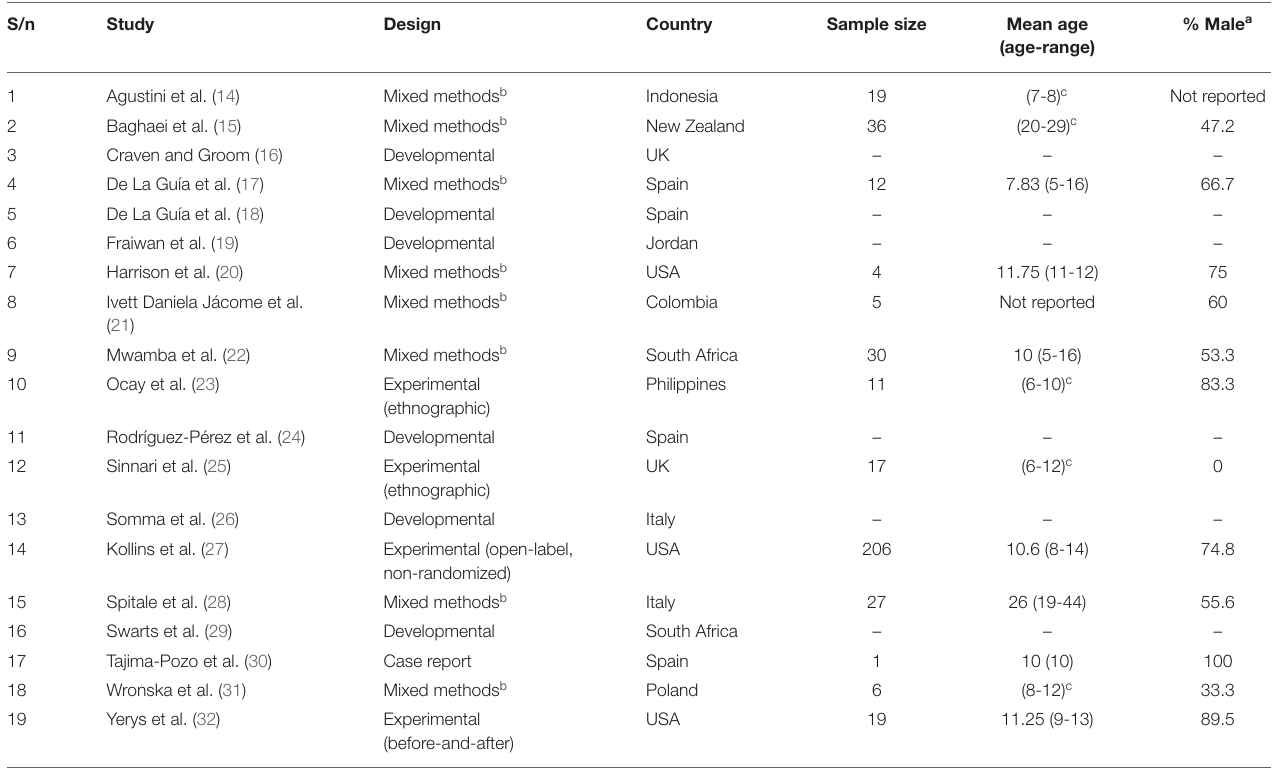
TABLE 1 | General characteristics of reviewed